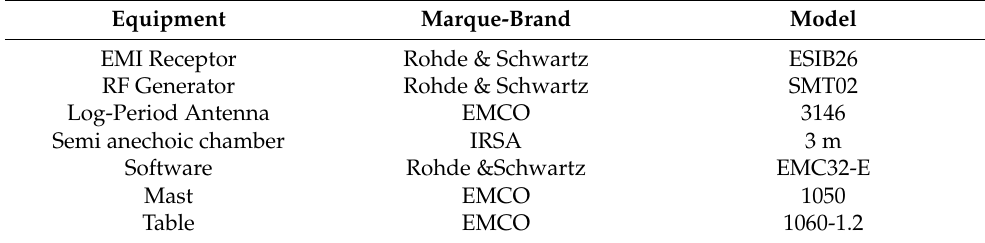
Measurement uncertainty: ± 3.81 dB of E-field strength; at duty cycle: